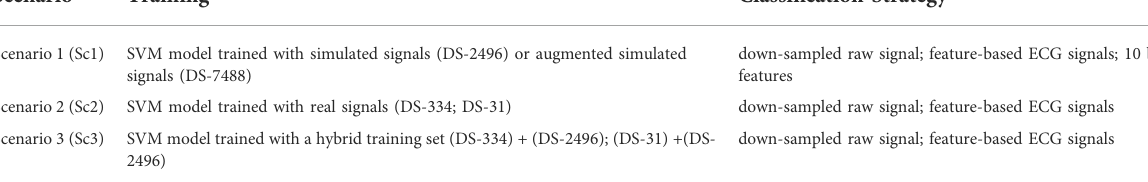
TABLE 1 Description of the different classi fi cation scenarios. Scenario Training Classi fi cation Strategy